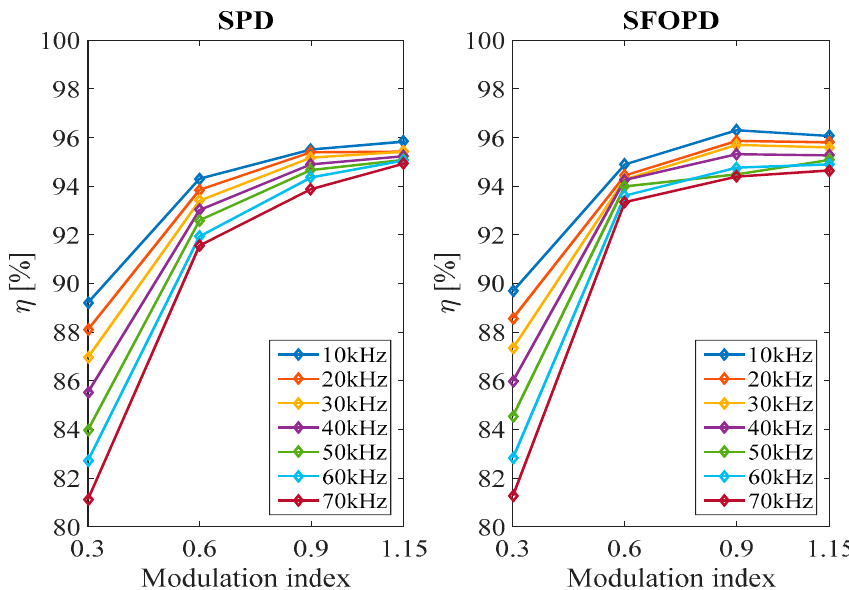
Figure 20. Experimental conversion efficiency trends of SPD and SFOPD schemes.